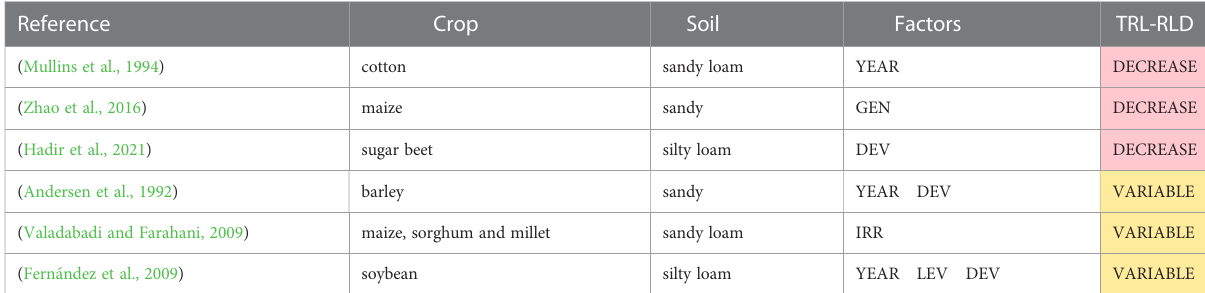
TABLE 8 Studies that report effects of K de fi ciency on total root length and/or root length density (TRL-RLD) at fi eld scale.